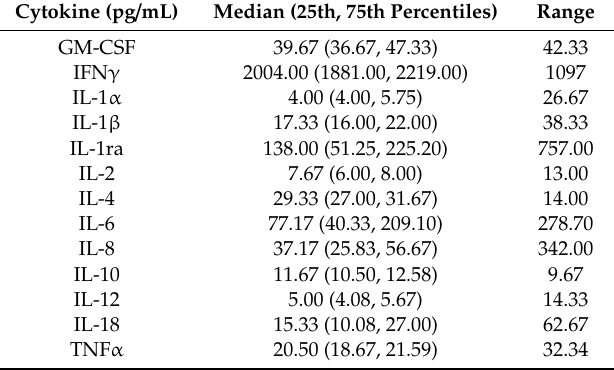
Table 4. Experiment 3: Cytokine concentrations in pig fresh seminal plasma samples (baseline samples, n = 20). Cytokines: Granulocyte macrophage colony-stimulating factor (GM-CSF),